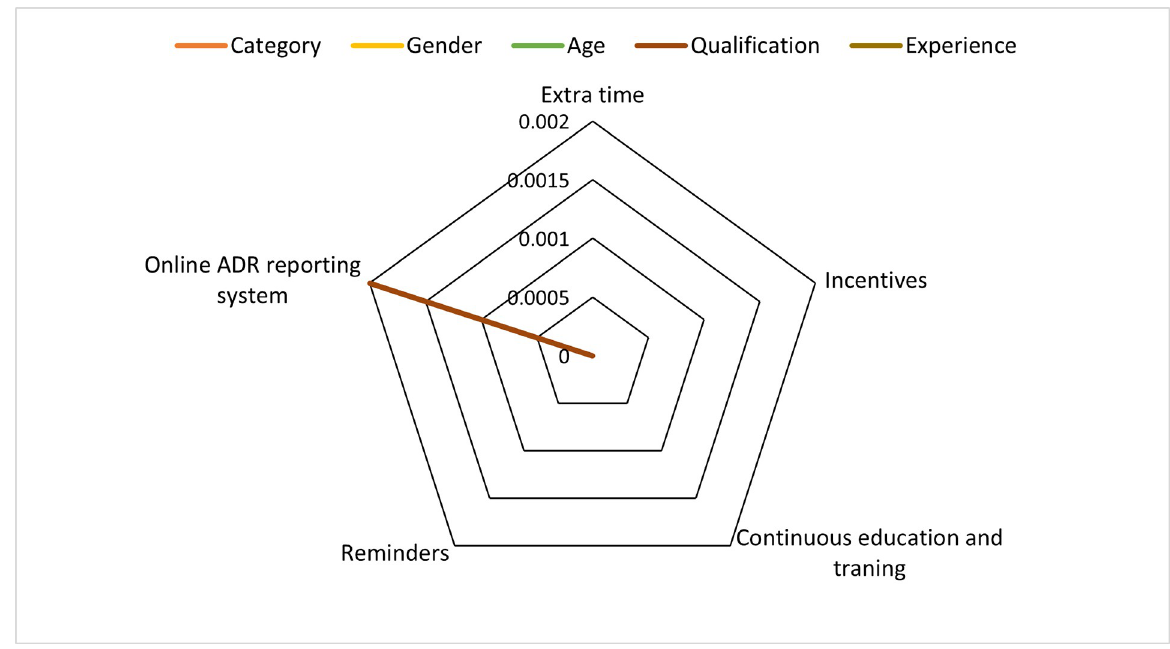
Fig 5. Analysis of facilitators based on demographic